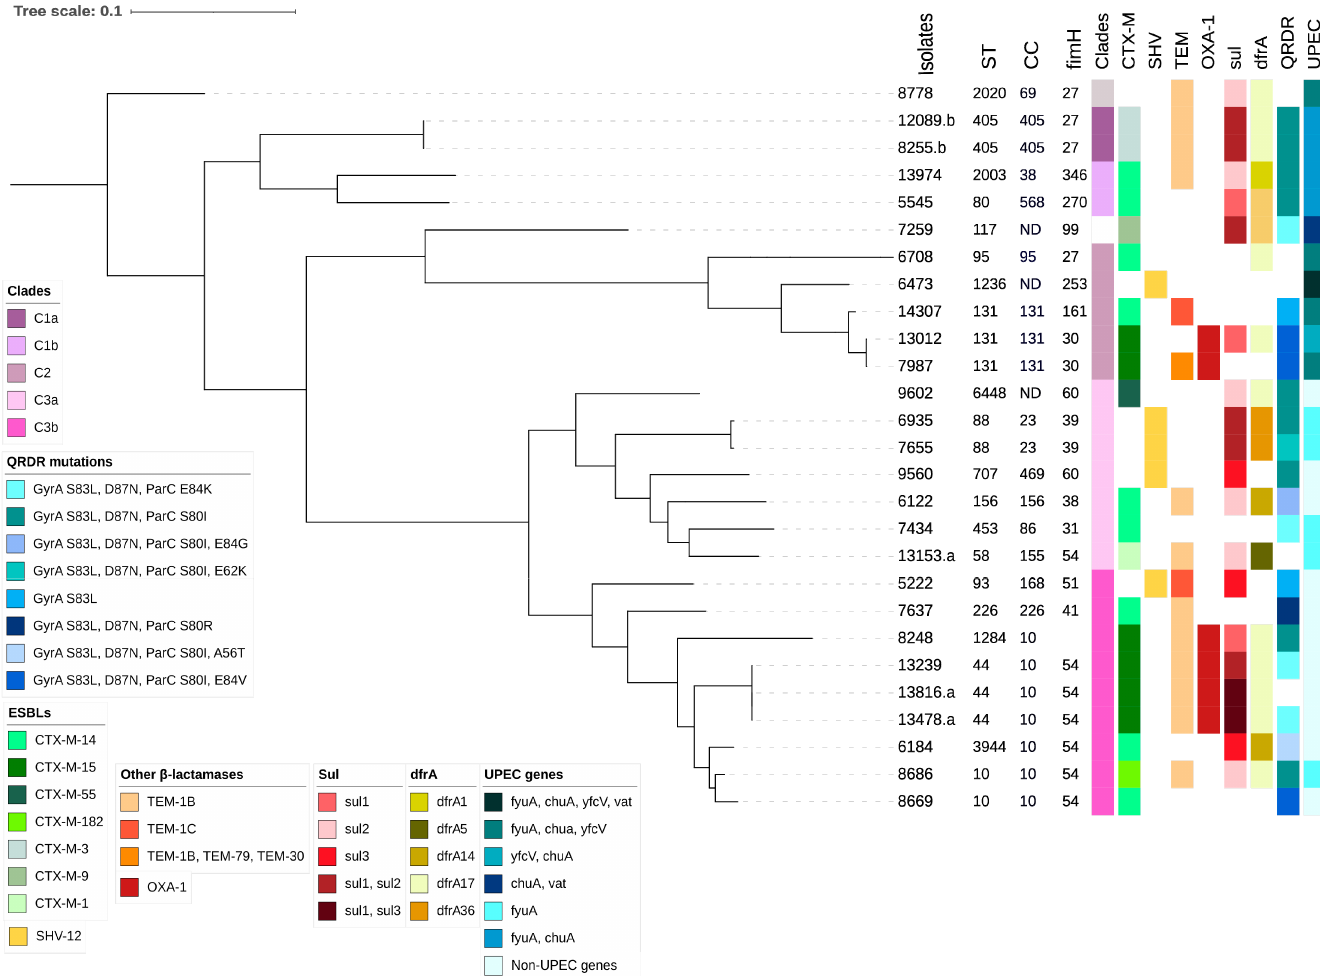
Figure 1. Phylogenomic analysis of E. coli isolates. Maximum likelihood tree of the 26 ESBL-MDR-EC isolates recovered from patients admitted to the Hospital de Cerdanya with a UTI during 2016 and 2017. The tree was rooted with E. coli 8778 ST2020. The clonal complex (CC), sequence type (ST), clade, antimicrobial resistance markers, and UPEC genes ( vat , fyuA , chuA , and yfcV ) relevant to the efficient colonization of the urinary tract are shown to the right of the tree.